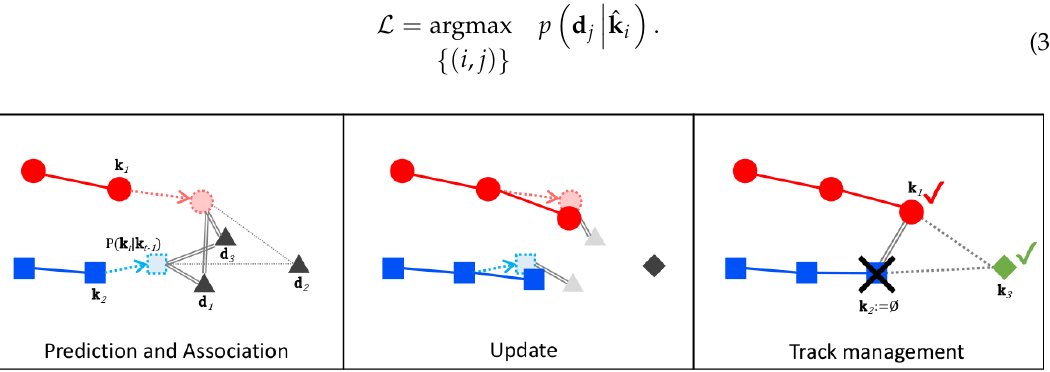
Figure 5. Illustration of the employed divide and conquer strategy. 1st step: predictions based on motion priors (dashed lines) are associated with observations (triangles). 2nd step: feasible tuples (double lines) are updated using the track management policy and, at the same time, other proposal moves such as adding or merging are also considered. e.g., on the right T 1 : {S blue , S red } × A merge (cid:55)→